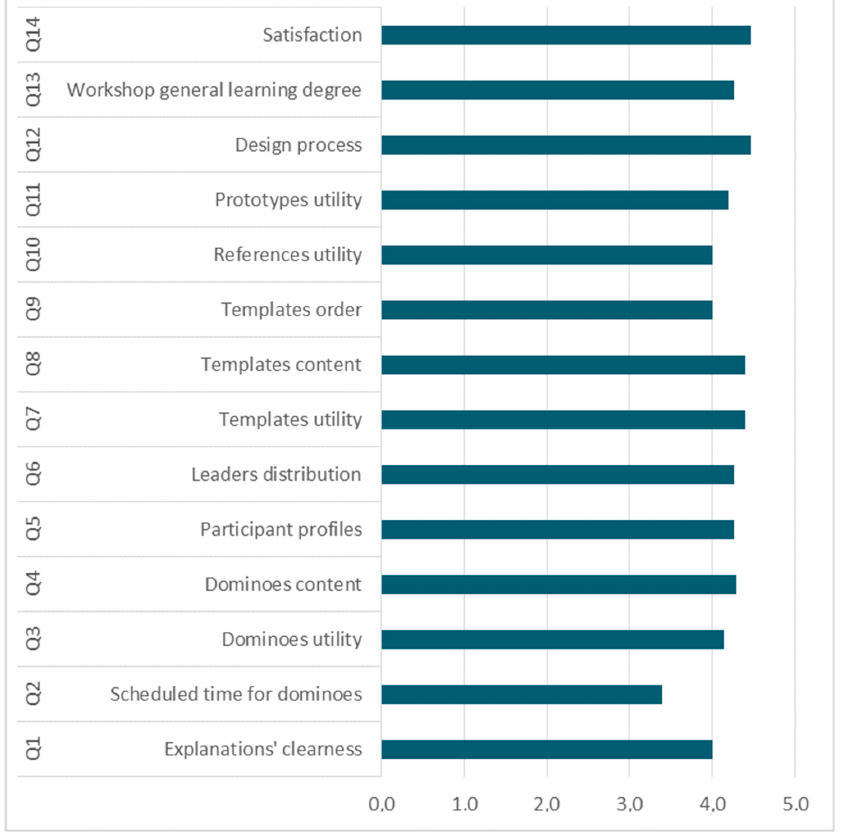
Figure 20. Participants’ answers on categorical scaled